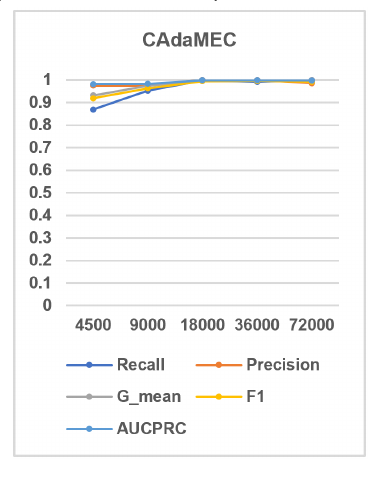
Figure 20. CAdaMEC: Impact of Dataset Size